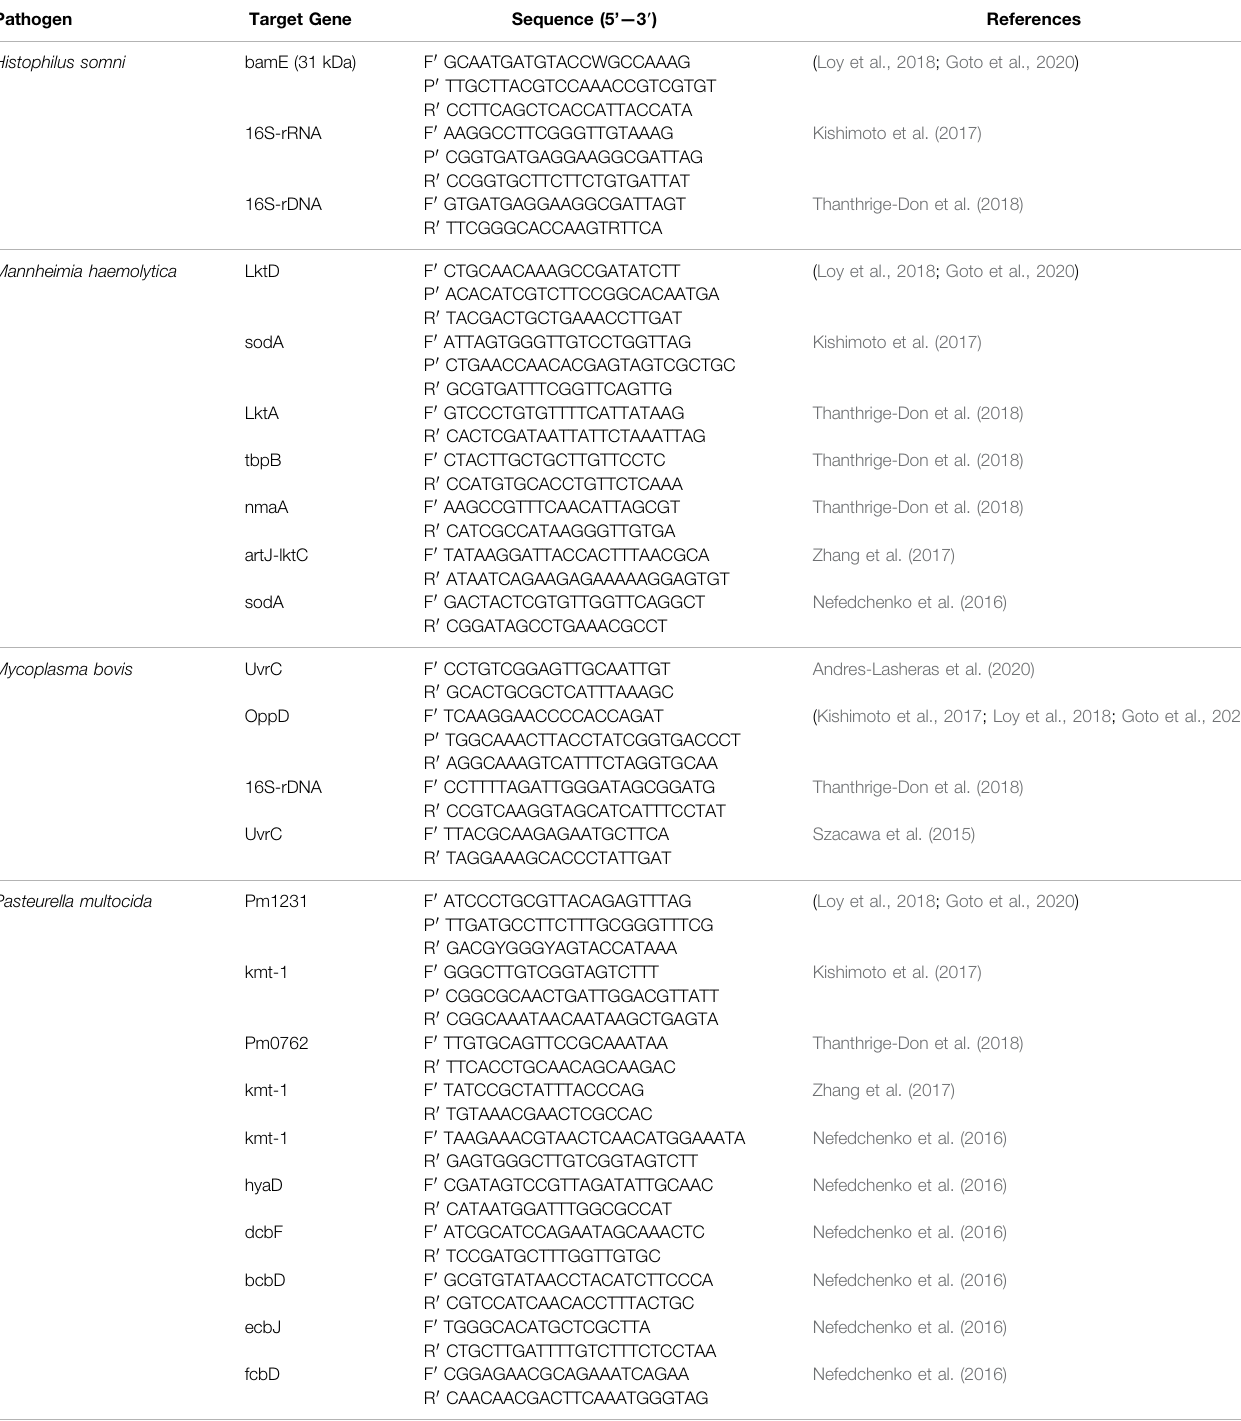
TABLE 6 | Published PCR primer and probe sequences for detection of bacterial pathogens associated with bovine respiratory disease complex. F ′ forward; P ′ probe, R ’ reverse sequences.